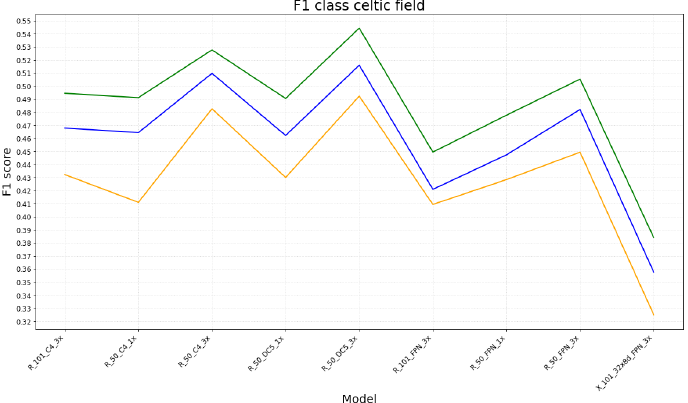
Figure 10. An experimental evaluation of the discrepancy between the pixel-based measure, in green ( (cid:110) ), the centroid-based, in orange ( (cid:110) ), and the semi-automatic GIS-based measure, in blue ( (cid:110) ), employed to assess the detection performance of nine different object detection networks in identi- fying Celtic fields. The pixel-based measure has the same trend of the GIS-based one. The average discrepancy between the two curves (green and blue) is less than